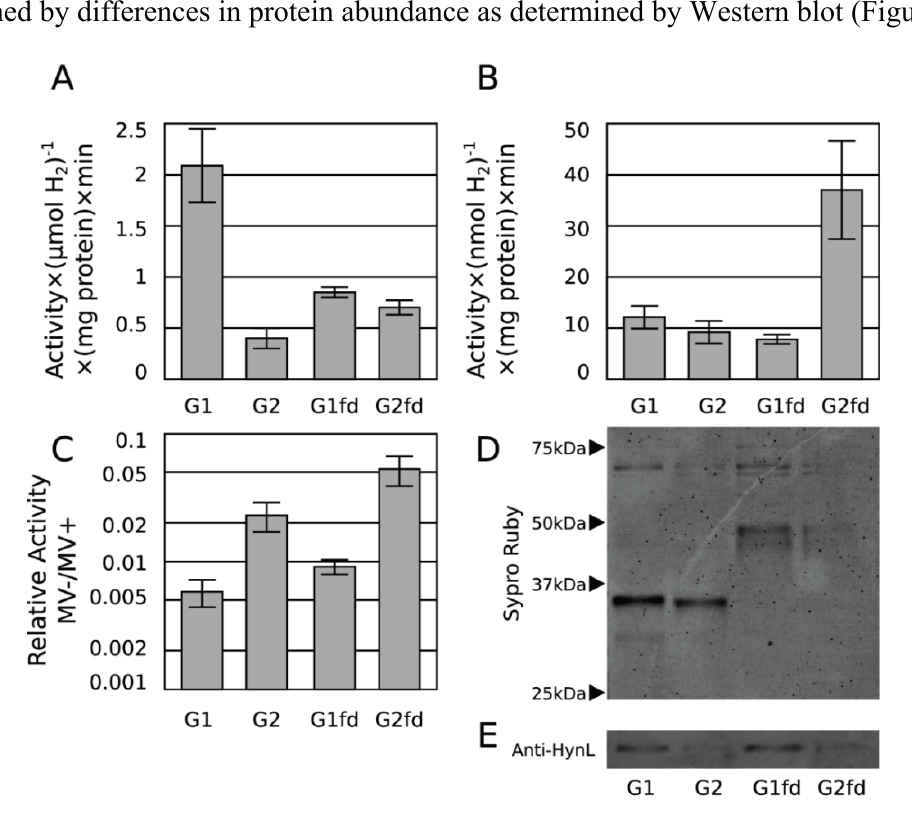
Figure 4. Methyl viologen-mediated in vitro hydrogen production assay ( A ) from tandem immobilized metal affinity chromatography (IMAC)/streptactin-purified G1 and G2 hydrogenases, and their respective ferredoxin fusions. In vitro H 2 production of the same hydrogenases in the methyl viologen-free assay (dithionite only) ( B ) and expressed as the ratio of methyl viologen-free activity to activity in assays containing methyl viologen ( C ), plotted on a log scale over an 100-fold range to compare fold-changes . Sypro-ruby stained gel ( D ) and Anti-HynL western blot ( E ) of the same constructs from the same protein preparations presented in ( A , B